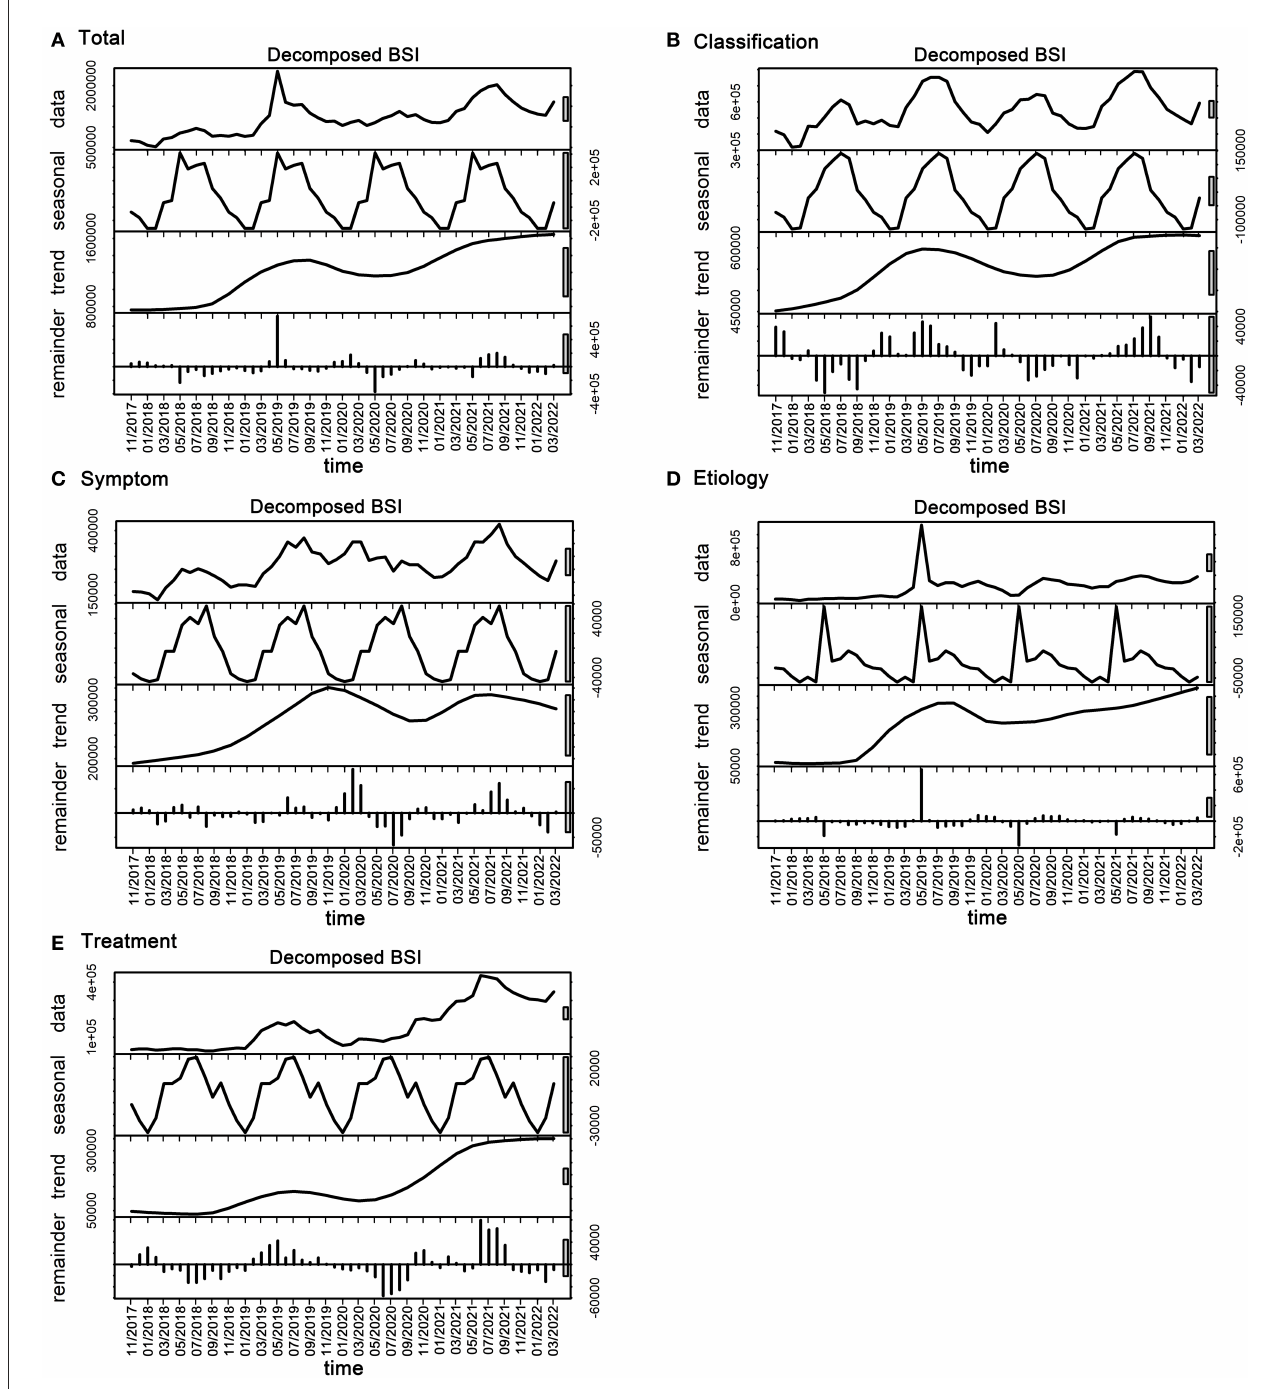
FIGURE3 Seasonal and trend decomposition for the monthly BSIs of (A) the total search and the four themes: (B) Classification, (C) Symptom, (D) Etiology, and (E) Treatment, from November 2017 to March 2022.